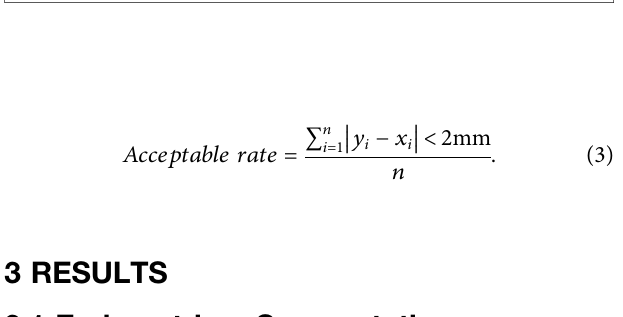
FIGURE 9 | Absolute endometrial thickness errors measured by the proposed